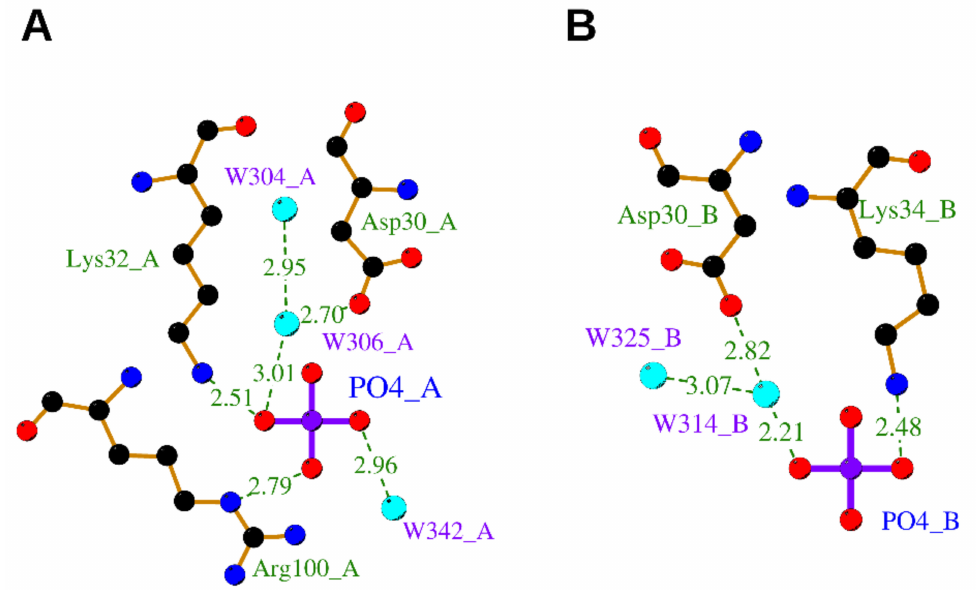
Figure 5. Binding sites of llama NGF complexed with phosphate ion. The binding of phosphate ion with protomer A and B is shown in panels ( A , B ), respectively. The ligands and protein side chains are shown in ball-and-stick representation, with the ligand bonds colored in purple. Hydrogen bonds are shown as green dotted lines. The 2D ligand–protein interaction diagrams have been produced with LigPlot+